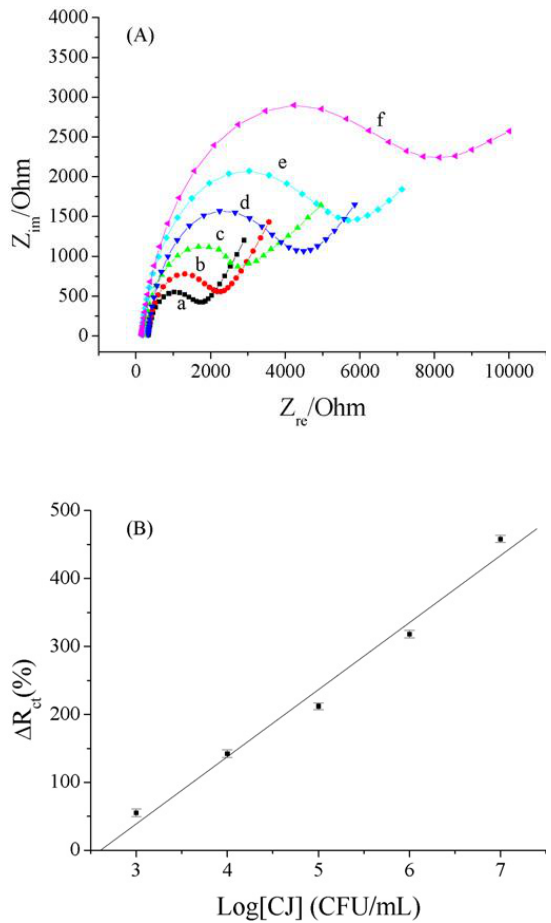
Figure 7. (A) Faradaic impedance spectra after the incubation of the immunosensor with different concentrations of CJ in 0.1M phosphate buffer solution (pH 7.0) and 0.1M KNO containing 1.0 mM Fe (CN) 63−/4−: (a) blank solution, curves (b)–(f) represent 1.0 × 10 3 , 1.0 × 10 4 , 1.0 × 10 5 , 1.0 × 10 6 and 1.0 × 10 7 CFU mL −1 Campylobacter jejuni , respectively. (B) Calibration curve for the immunosensor